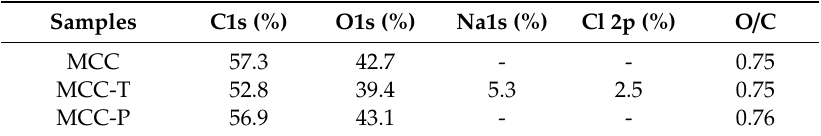
Figure 5. XPS survey spectra of different treated MCC . Table 1. The elemental surface composition, in atomic %, from XPS survey spectra before (MCC) and after the treatments (MCC ‐ T and MCC ‐ P) .